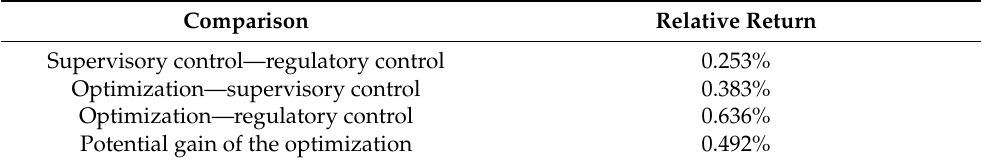
Table 10. Relative return comparing the operational modes.